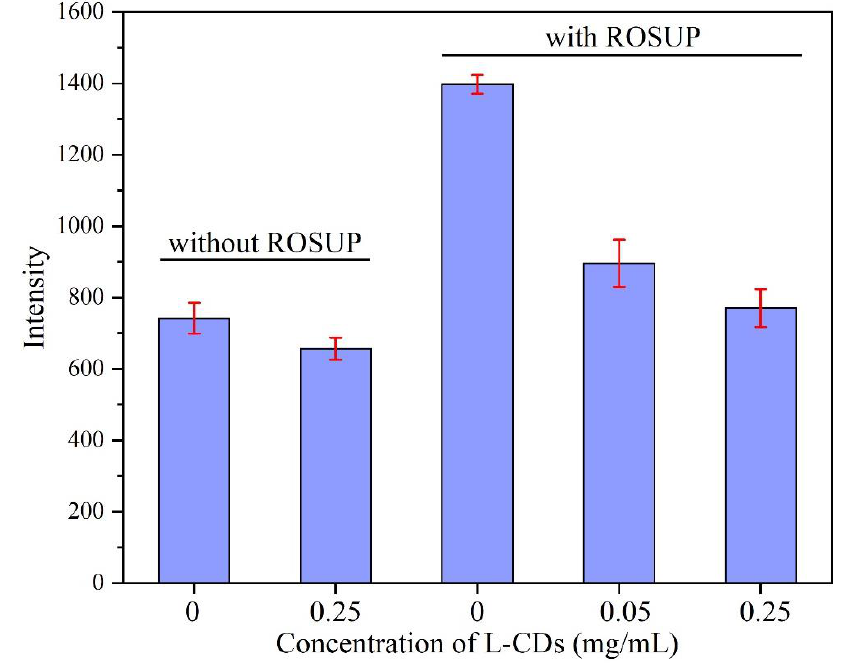
Figure 6. Fluorescence intensity of 2’,7’-dichlorofluorescein (DCF) in cells with versus incubation concentrations of L-CDs with or without ROS reagent (ROSUP).